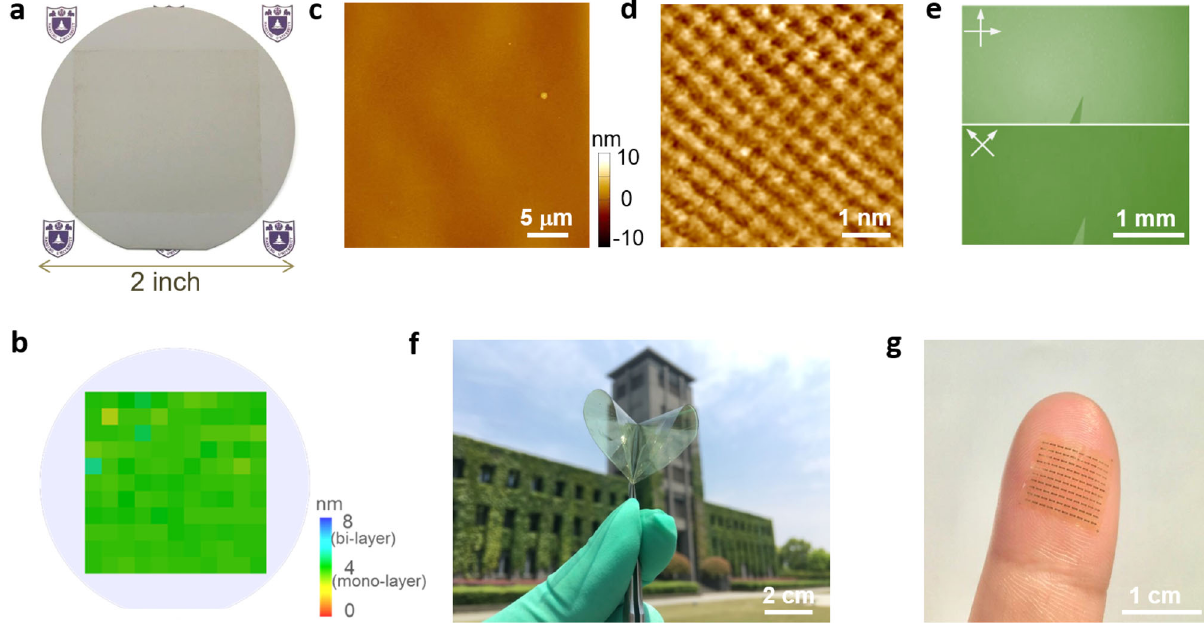
Fig. 1 Large-area monolayer C 10 -DNTT fi lms. a Photograph of uniform monolayer C 10 -DNTT fi lm on 2-in. Si wafer. b The thickness mapping of the sample in a using spectral ellipsometry. AFM ( c ), high-resolution AFM ( d ) and cross-polarized optical micrograph ( e ) of the monolayer C 10 -DNTT fi lm. Photograph of monolayer C 10 -DNTT fi lm on polyimide substrate ( f ) and fl exible device array laminated on a fi ngertip ( g